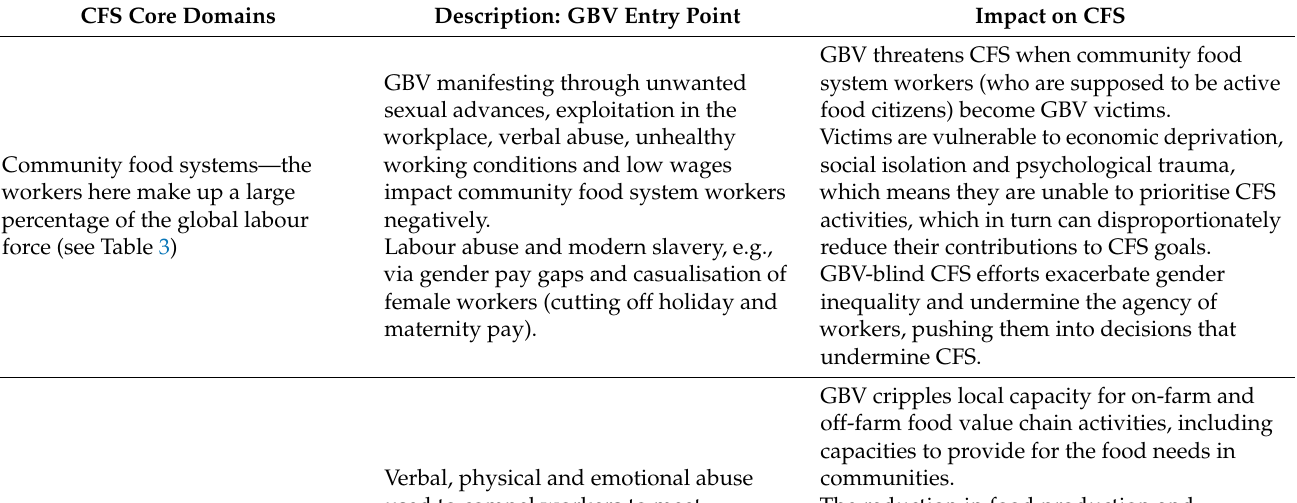
Table 1. Cont . Table 2. An overview of the ways in which GBV-related harms to community food security